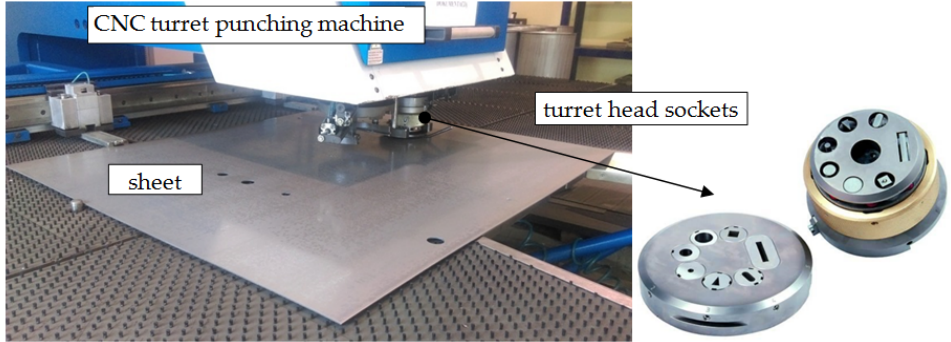
Figure 2. Nibbling Figure 2. Nibbling equipment.